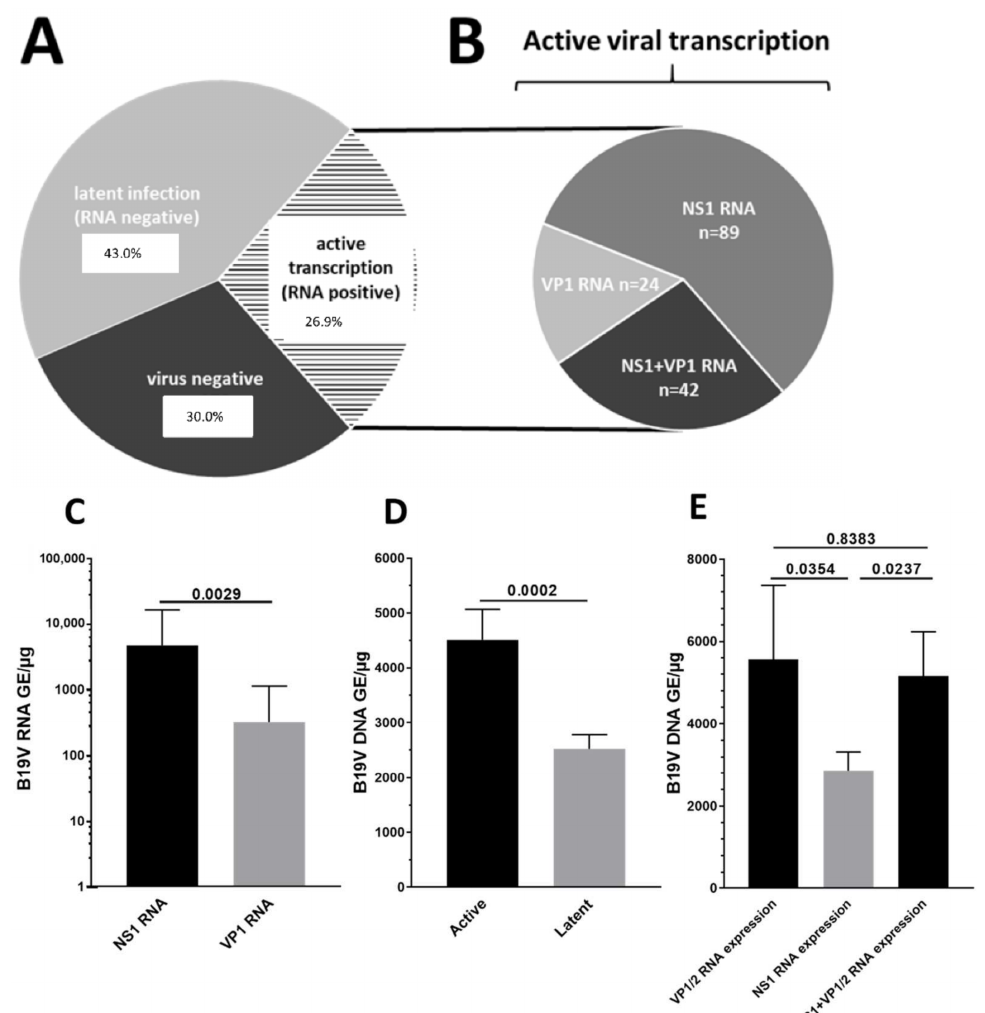
Figure 5. ( A ) Parvovirus B19 (B19V) genome detection and detection of viral transcription activity in EMBs of patients with unexplained heart failure ( n = 576). ( B ) The group composition of EMBs with detectable active viral transcription (VP1/2-RNA-, NS1-RNA and VP1/2 and NS1-RNA positive samples) was shown in detail. Numbers represent the amount of EMBs. ( C ) The number of viral transcripts of NS1 compared to VP1/2. ( D ) Viral DNA loads in EMBs with active or latent infection. ( E ) Viral DNA load compared between EMBs with detectable VP1/2-RNA, NS1-RNA or NS1- and VP1/2-RNA expression (ANOVA p = 0.0427). Numbers above the bars represent p -values. Modified from